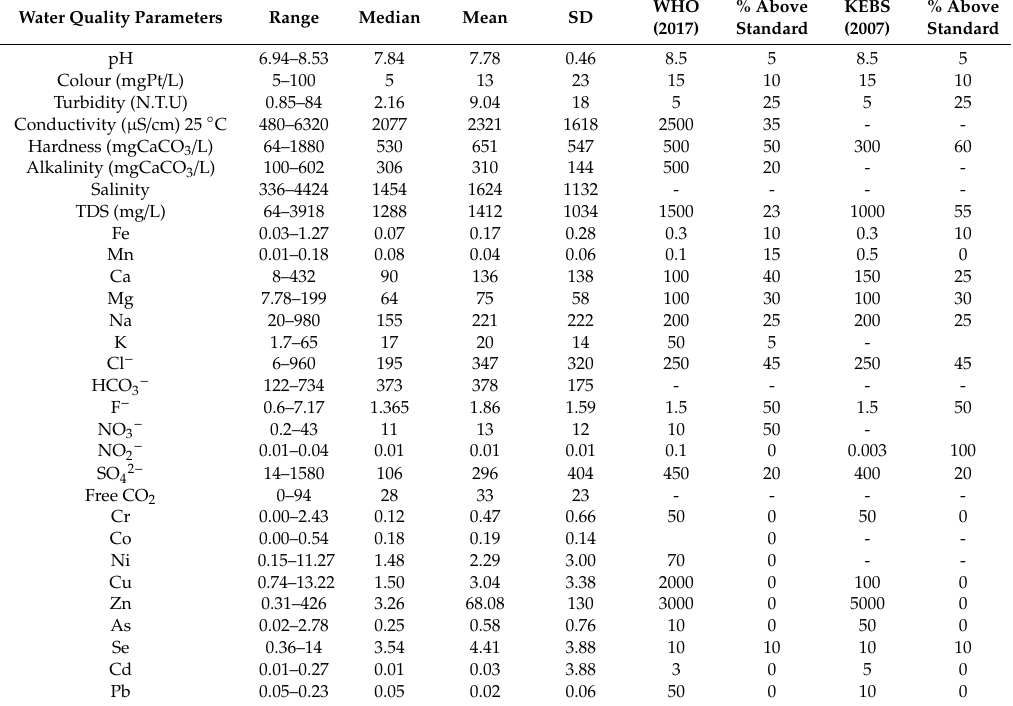
Table 1. Statistical results (range, median, mean, standard deviation) of the analysed water samples from Makueni County, World Health Organization (WHO), and Kenya Bureau of Standards (KEBS) standards recommended limits and percentage of samples with parameters above these